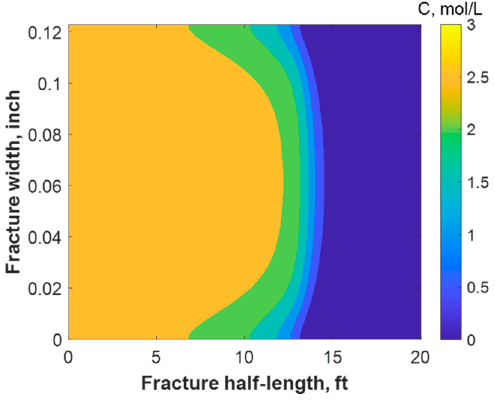
Figure 8. 2-D concentration profile of the TCs inside the fracture at the final time step.